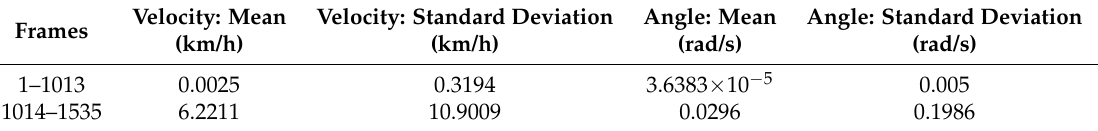
Table 6. GPGPU errors after Posterior stage.